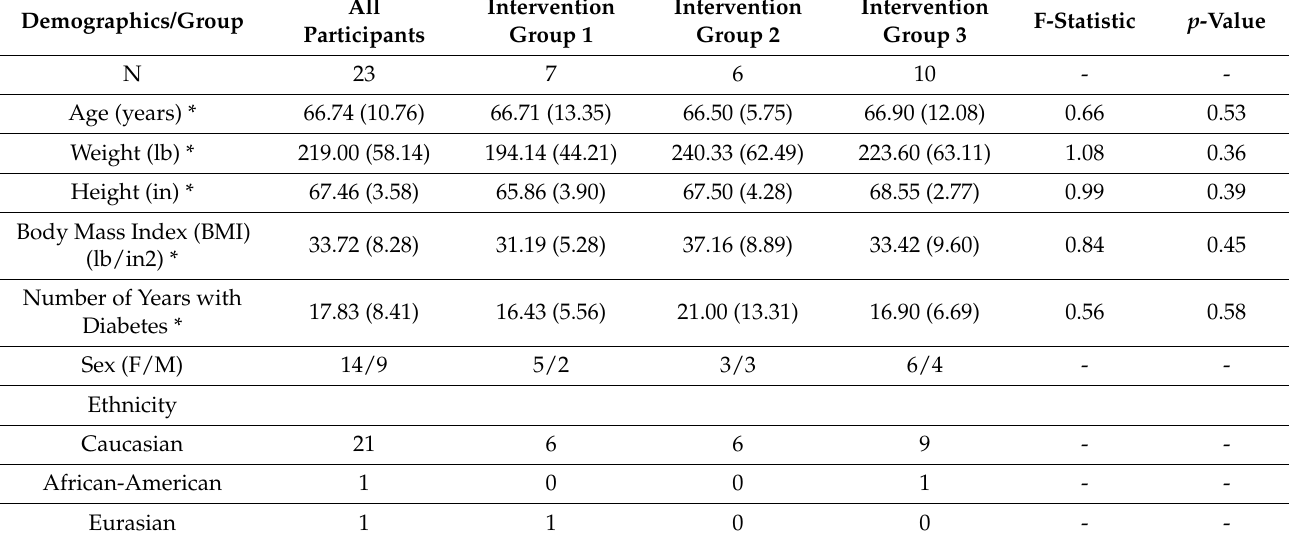
Table 1. Patient demographic information #